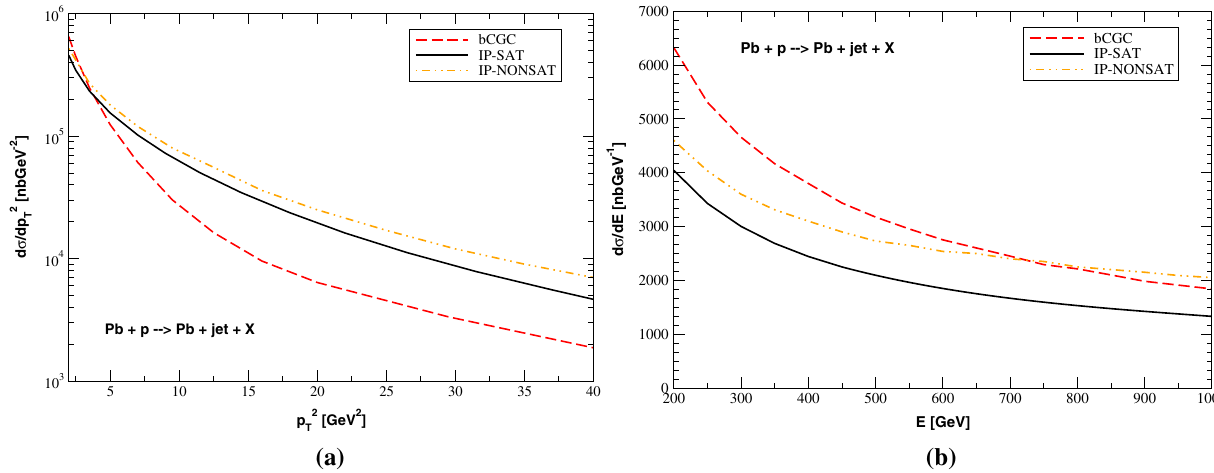
Fig. 5 Predictions for the a transverse momentum distribution and b energy spectrum for the single inclusive jet photoproduction at very forward √ s = 5 . 02 rapidties in pPb collisions at